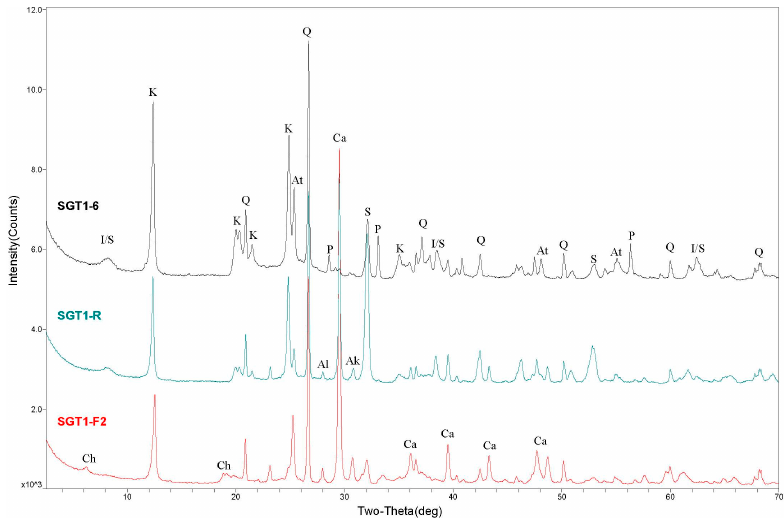
Figure 5. X-ray powder diffraction (XRD) patterns showing minerals in sample SGT1-6 (carbonaceous rock), SGT1-R (roof) andSGT1-F2 (floor). I/S: mixed layers illite/smectite, K: kaolinite, Q: quartz, At: anatase, P: pyrite, Ca: calcite, S: siderite, Al: albite, Ak: ankerite, Ch: chamosite.